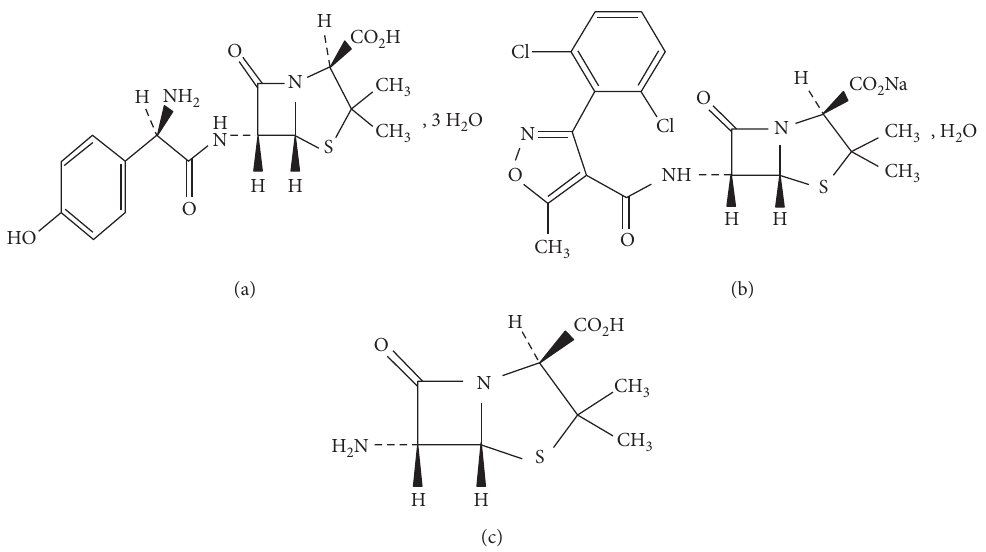
Figure 1: The chemical structure of AMOX (a), DIC (b) and their common impurity 6-APA